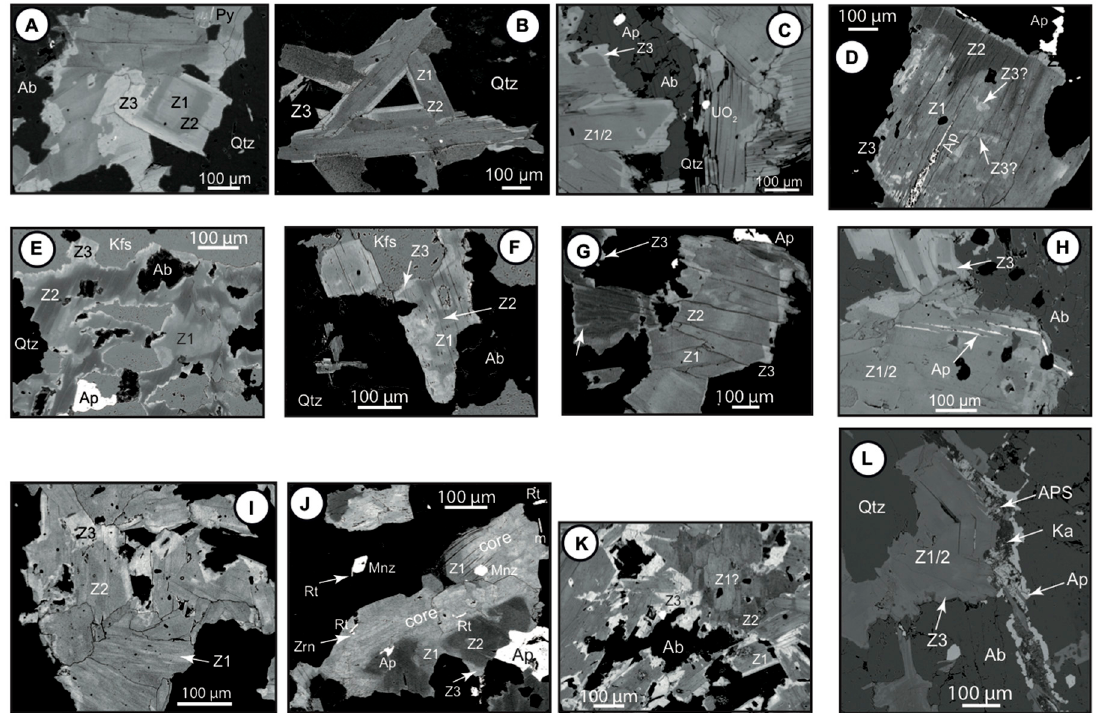
Figure 6. SEM-BSE images of muscovite zoning. The zoning pattern consists of three zones with a grey core (Z1), a darker first rim (Z2), and a bright second rim (Z3). Ab albite, Ap apatite, APS alumina-phosphate-sulfate, Kfs K-feldspar, Rt rutile, Mnz monazite, Qtz quartz, Zrn zircon. A to C : muscovite from the greisenised G4 granite. ( A ) L2 level (sample PNQ-19a). A clear succession of the three zones (Z1 to Z3) is visible, although patchy zoning features are also evident. ( B ) L0 level (sample PAN-VI-17a2-1). The Z1 to Z3 succession is well seen. ( C ) L2 level, contact with the wall rock (sample PNQ-13a). Privileged Z3 development occurs along the muscovite/albite boundary. Note the uraninite inclusion. ( D – E ) Muscovite in granites from the G1 suite. ( D ) Muscovite strips in the Kfs from the porphyritic granite G1a (sample PAN16-6). Patchy zoning with clear superimposition of Z2 onto Z1. ( E ) Greisenised G1b granite (sample PAN16-4a). Note the ingress of Z3 onto the patchy Z1/2 assemblage. ( F ) Altered G2 granite (sample PAN16-8). Note the concentric Z1 to Z3 pattern. Arrow: Z3 invasive along cleavage. ( G ) Altered leucomicrogranite (aplite) G3 (sample PAN16-9). Note the conspicuous Z3 rim and the residual character of the Z1 zone within the main Z2 zone. ( H , I ) Possible relicts of an altered magmatic Li-mica. ( H ) In some crystals from the greisenised G1b granite (sample PAN16-3b), the existence of a bright “core”, with rutile inclusions, may be tentatively interpreted as resulting from the replacement of a pre-existing Ms0-rutile assemblage developed at the expense of a pristine protolithionite; m is molybdenite. ( I ) Some bright areas in the core of muscovite from the greisenised G4 granite (sample PNQ-13a) may be tentatively interpreted as relicts from a pre-existing Li-mica (Z1?). ( J–L ) Muscovite-apatite relationships. ( J ) Altered G2 granite (sample PAN16-8). Note the invasive character of the Z3 zone and the presence of late apatite along the cleavage. Small Fe-rich patches inside Z1 (Z3?) are possible ghosts of an earlier Li-mica. ( K ) Patchy zoning in the muscovite from the greisenised G4 granite near the wall-rock boundary (sample PNQ-13a). The Z3 zone is encroaching the earlier muscovite. Note the clear overprinting by apatite (Ap). ( L ) Microcracks filled with apatite are encroaching the zoned muscovite and the albite in the altered G2 granite. Apatite is replaced by an APS-kaolinite (Ka) assemblage (see Figure